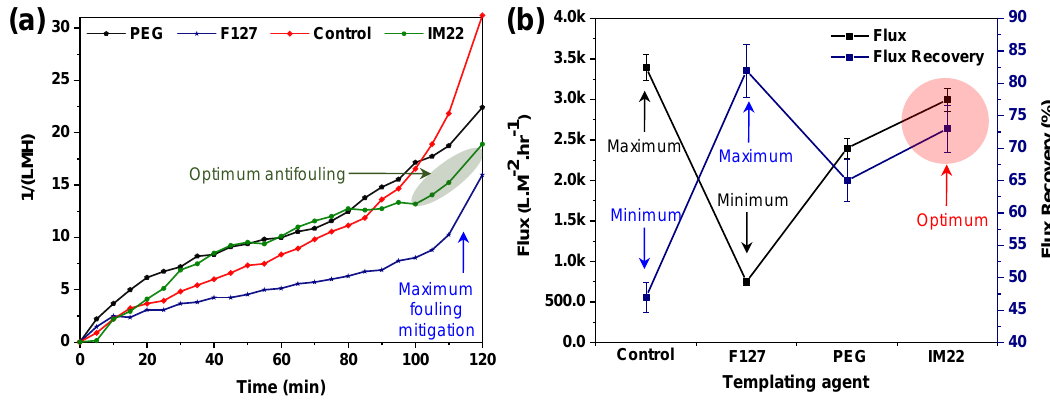
Figure 7. ( a ) The fouling trends of neat nanocomposite TiO 2 membrane plus modified membranes via F127, PEG, and IM22 template agents and ( b ) water flux and flux recovery of the modified and control membranes.